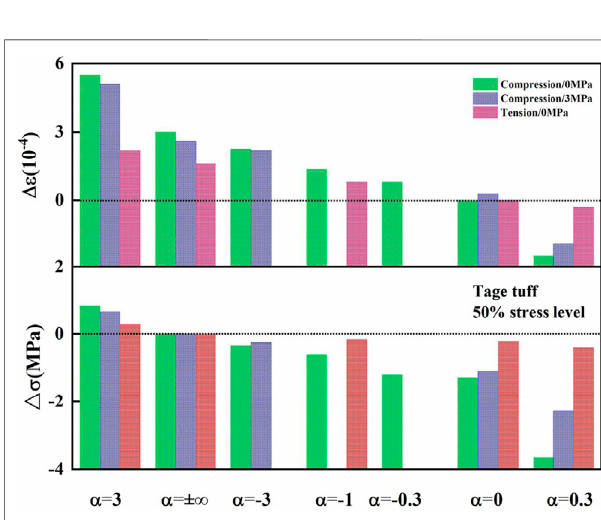
FIGURE 7 | The relationship between Δ σ , Δ ε and α of Tage tuff at 10 4 s under uniaxial compression, tension, and triaxial compression for 50% stress